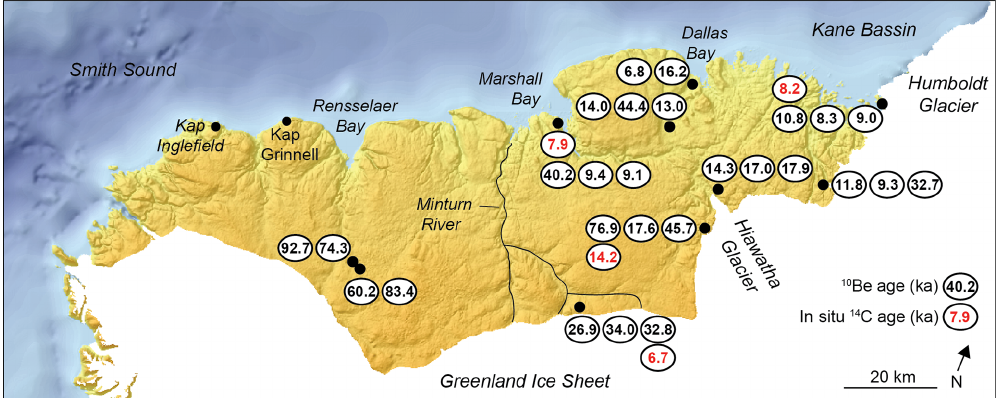
Figure 3. Map of Inglefield Land, north Greenland. Black dots denote sample locations for boulder samples and their resulting 10 Be and in situ 14 C exposure ages given in thousands of years (ka). 10 Be age uncertainties range between 0.3 and 7.3ka with an average of 1.4ka and 14 C age uncertainties range between 0.3 and 0.5ka with an average of 0.4ka.